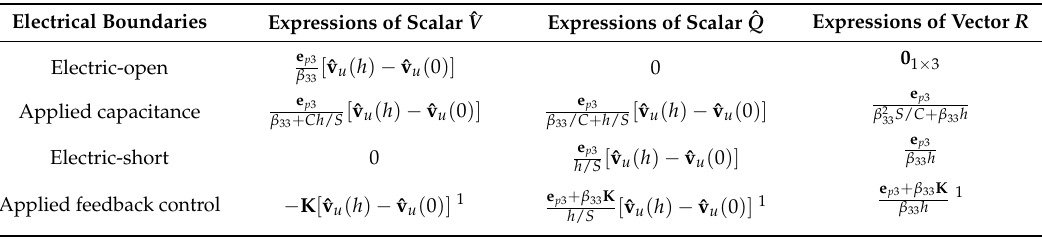
Table 2. The involved expressions relative to electrical